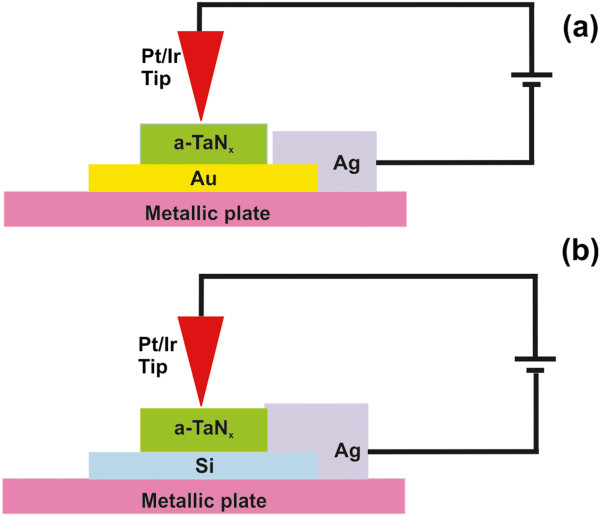
Simplified diagrams of C-AFM and devices. (a) The Pt/Ir-TaNx-Au device. (b) The Pt/Ir-TaNx-Ag device.